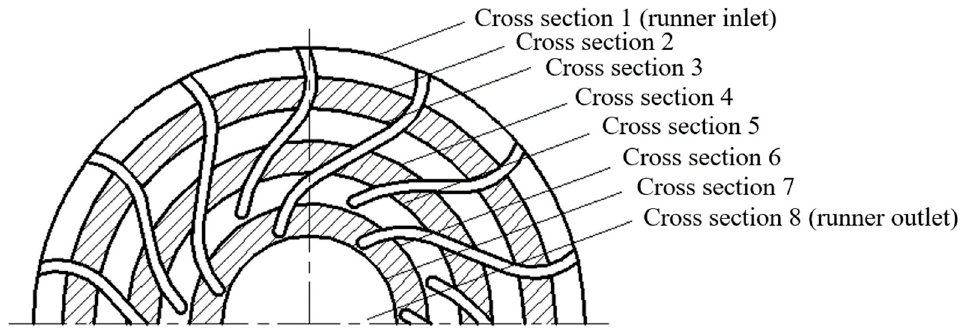
Figure 7. Schematic diagram of the runner partition.